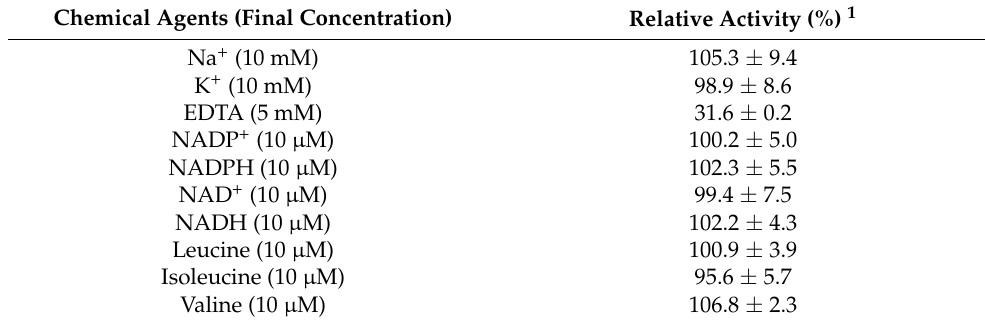
Figure 3. Effects of different temperatures ( a ) and pH ( b ) on the enzymatic activity of AlsS1 and Lineweaver–Burk plot of AlsS1 ( c ). The pH effect was measured in sodium acetate buffer (diamond), sodium phosphate buffer (circle), or glycine-sodium hydroxide buffer (uptriangle). Data were expressed as mean ± standard errors of three replicates. Table 3. Effects of metal ions, cofactors, and branched-chain amino acids on AlsS1